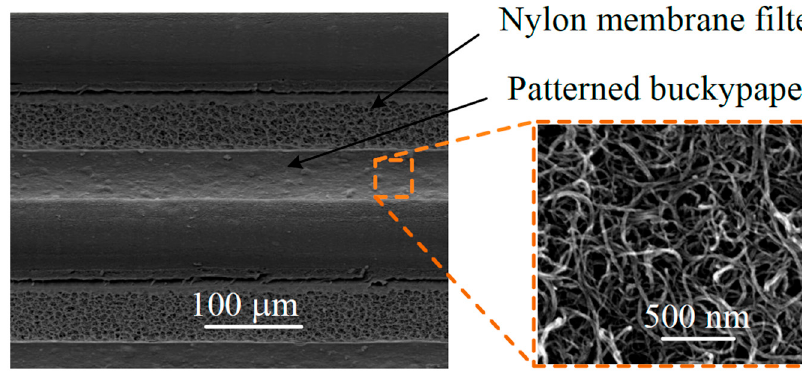
Figure 5. SEM images of the micro-SC.